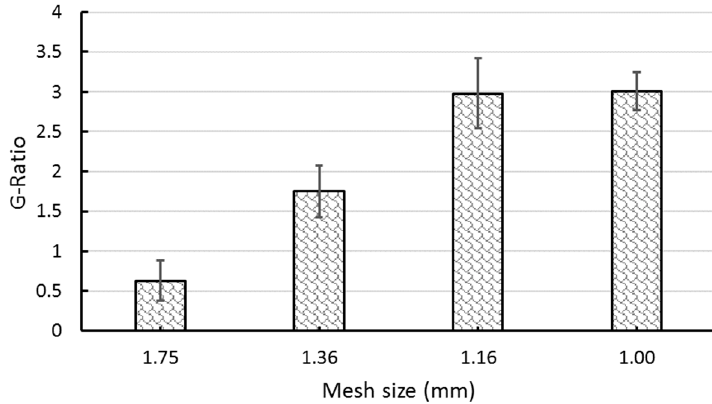
Figure 8. Relationship between G-ratio and mesh opening, average value, and deviation.